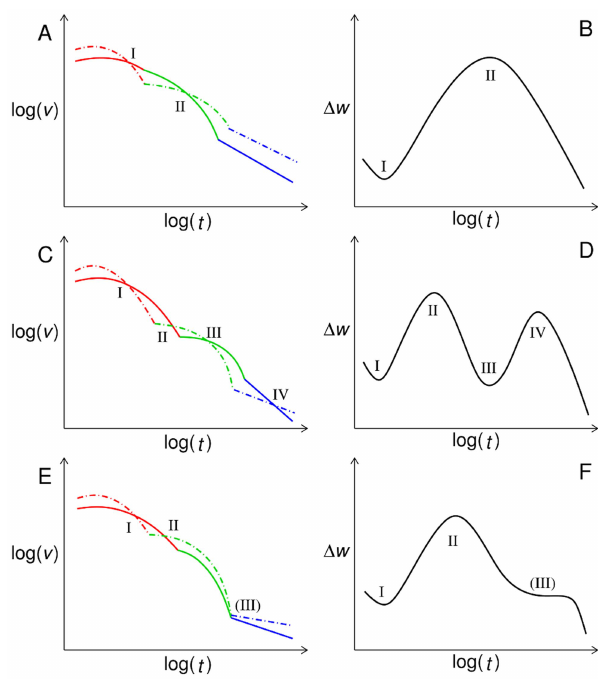
Figure 8. Summary of scenarios for a transient advantage of recombination. The figure shows schematic plots of fitness velocities v r (solid lines), v nr (dashed lines) (A, C, E) and the corresponding behavior of D w (B, D, F). Red, green and blue line segments correspond to the initial, ASD and final regime, respectively. Latin numbers indicate intersections of the velocities and the corresponding extrema in D w ( t ) . The last number in panels E and F is written in parenthesis to indicate that the two curves do not actually intersect but come very close to each other.